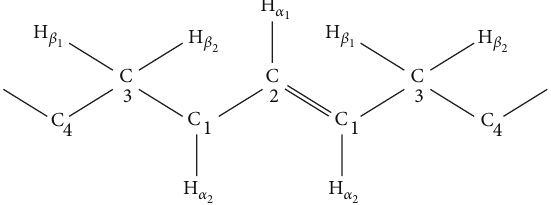
Figure6:Configurationof “allyltype”radicalshowingthepositions of 𝛼 - and 𝛽 -hydrogen